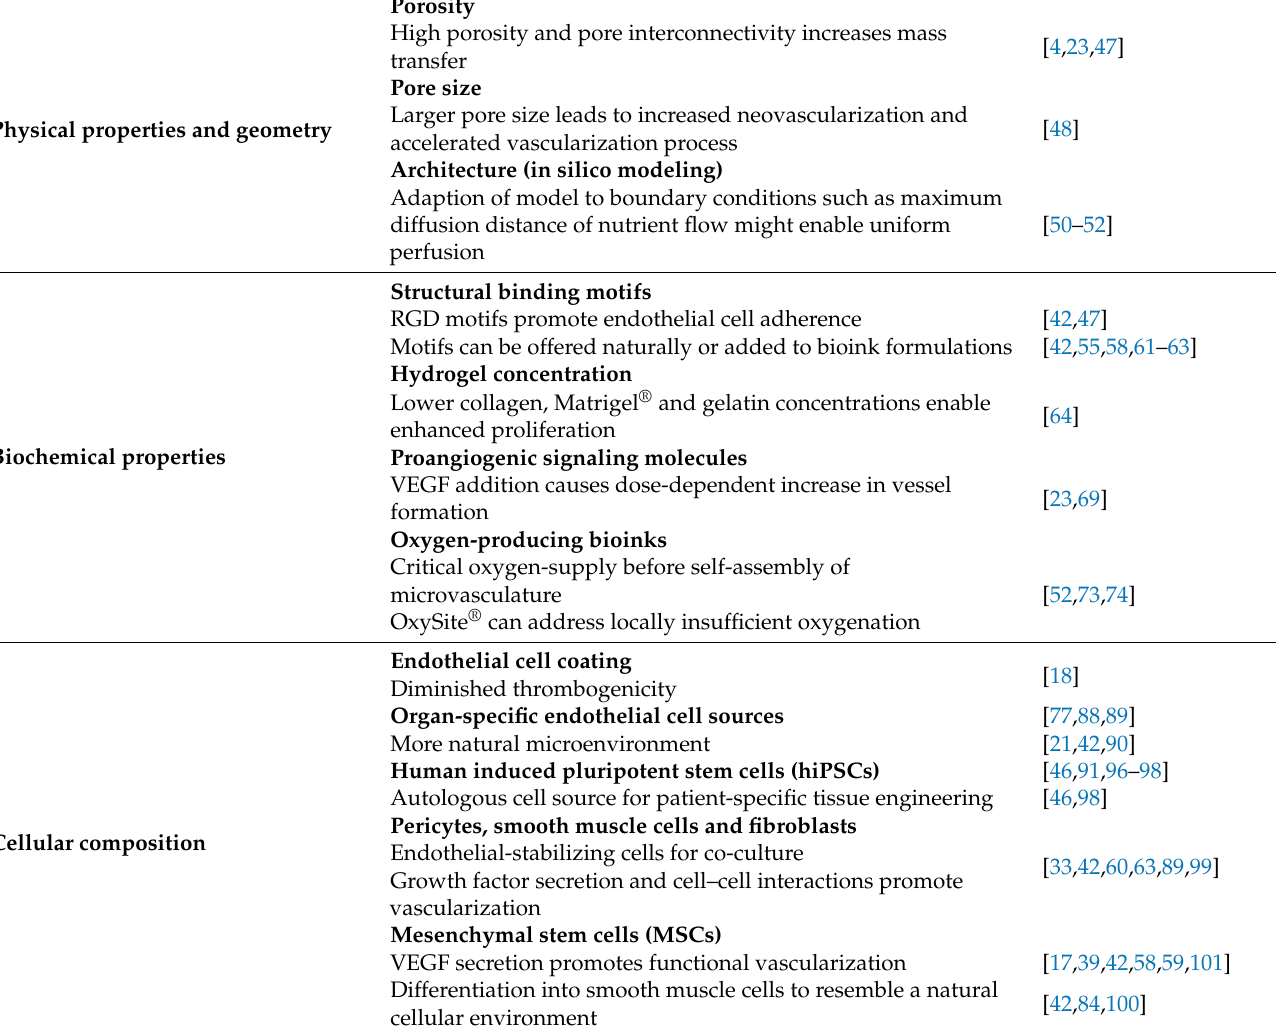
Table 1. Overview: Bioink properties and composition can influence